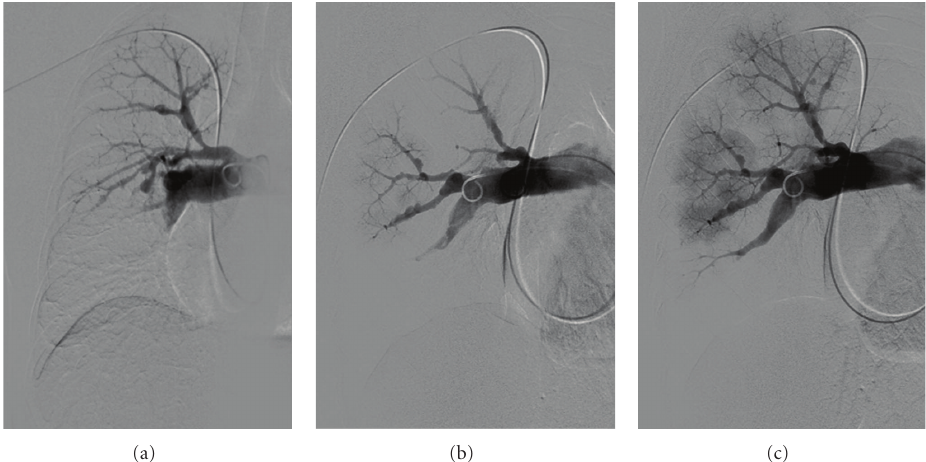
Figure 1: Pulmonary angiography suggestive for chronic thromboembolic pulmonary hypertension (CTEPH) with unexplained multiple dilatations of the branches of the right upper lobar artery.